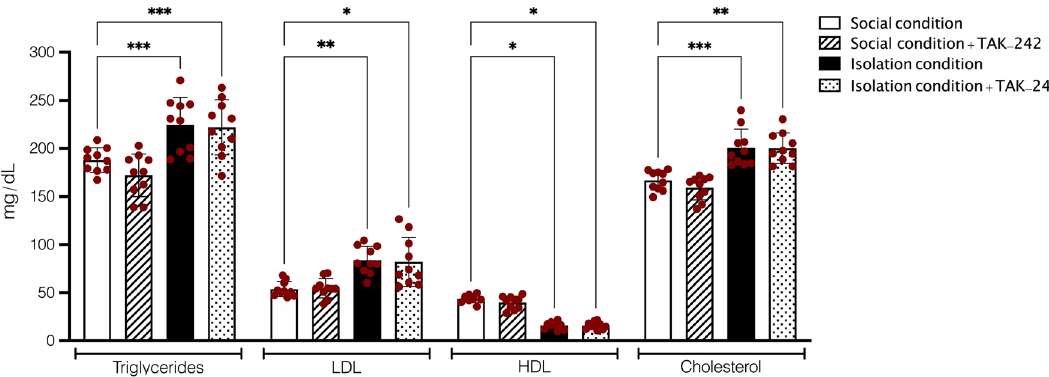
Figure 2. Results of plasma concentrations of lipid profile components in socially isolated and normal animals. Values are expressed as the mean ± S.E.M. (n = 10 in each group) results were analyzed using One-Way ANOVA followed by Tukey’s post hoc test. *** P < 0.001 compared to social conditioned animals.